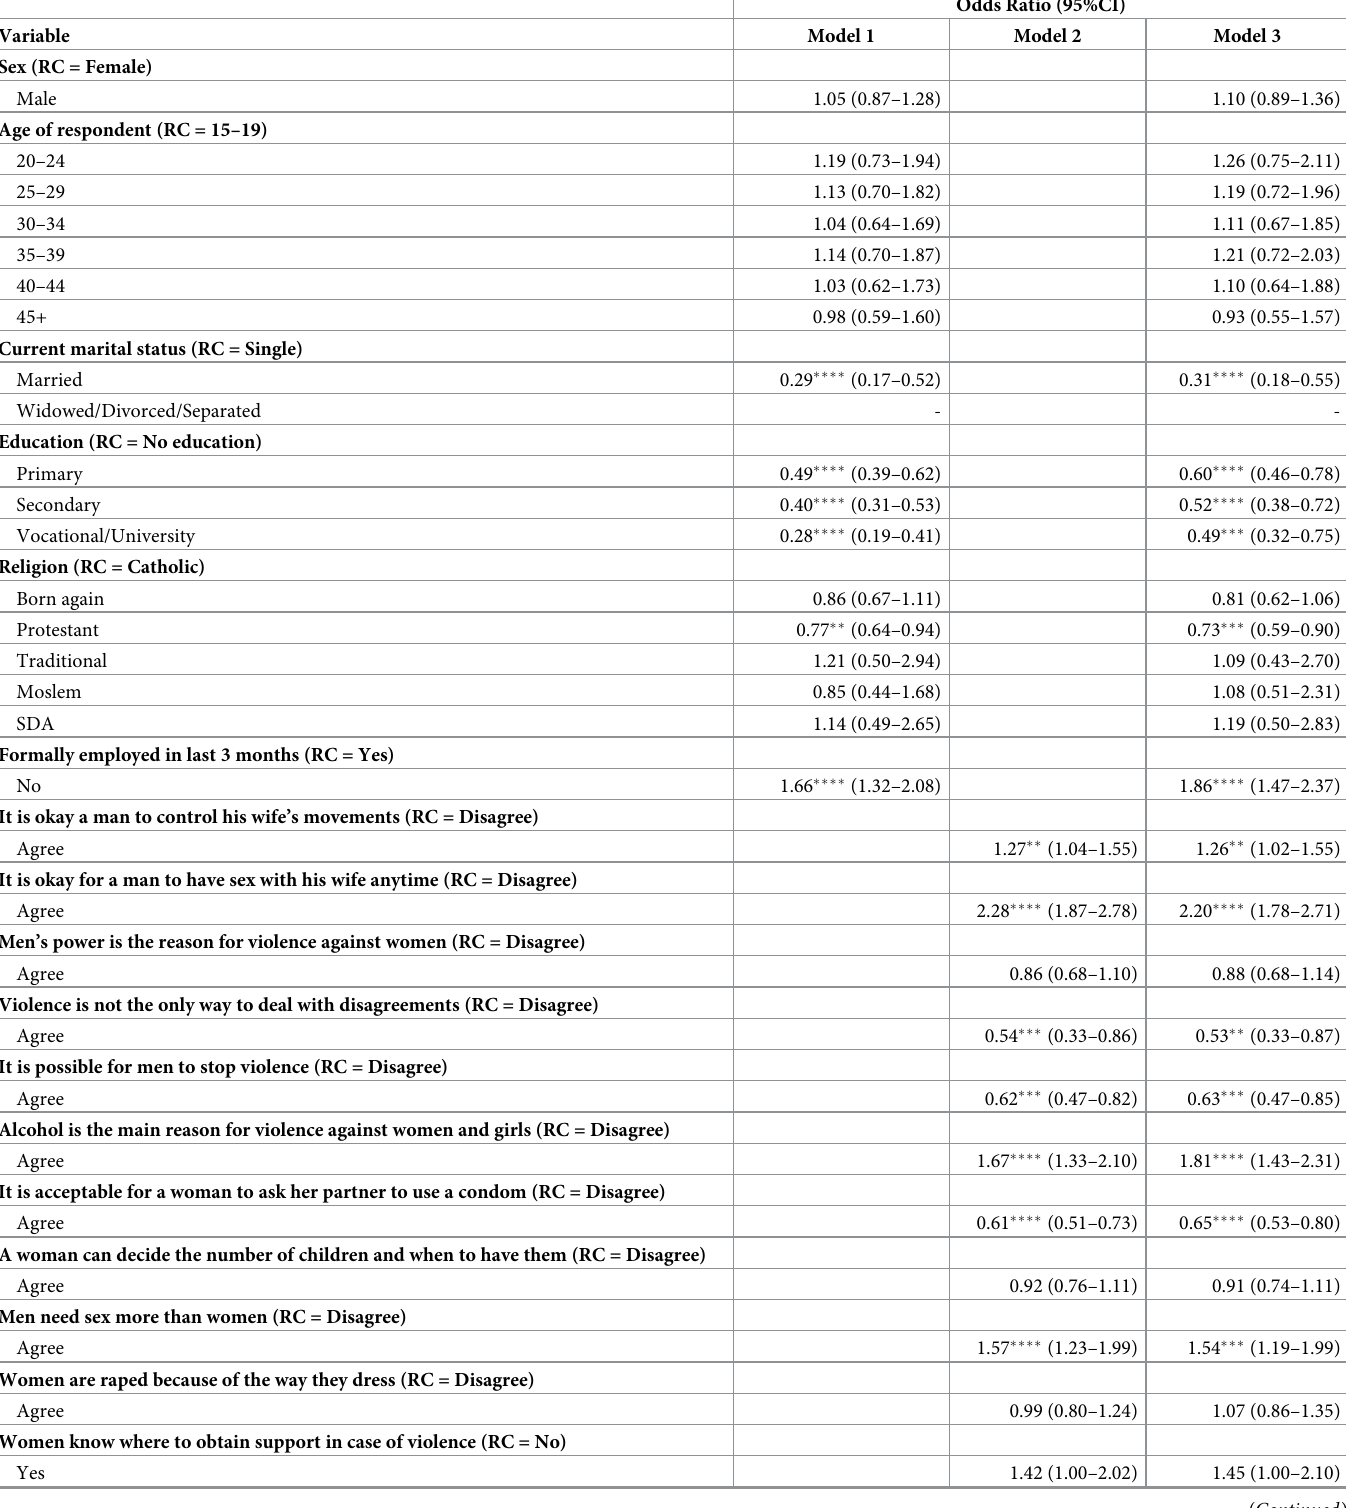
Table 5. Factors associated with justification of physical violence against